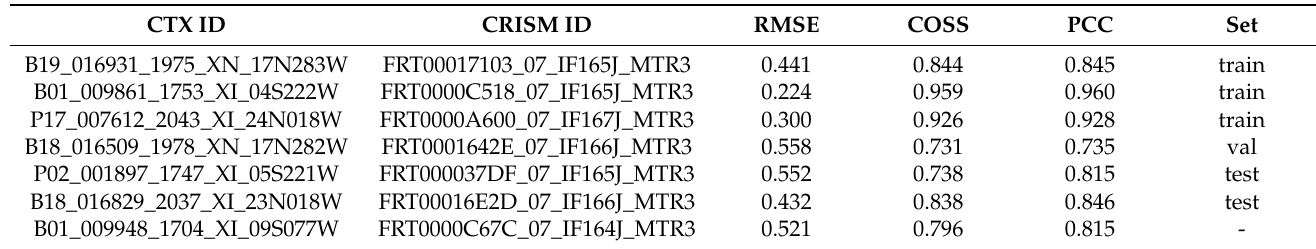
Table 7. Ablation study of evaluated full EVC images. All images were computed with a stride of 2 and Gaussian